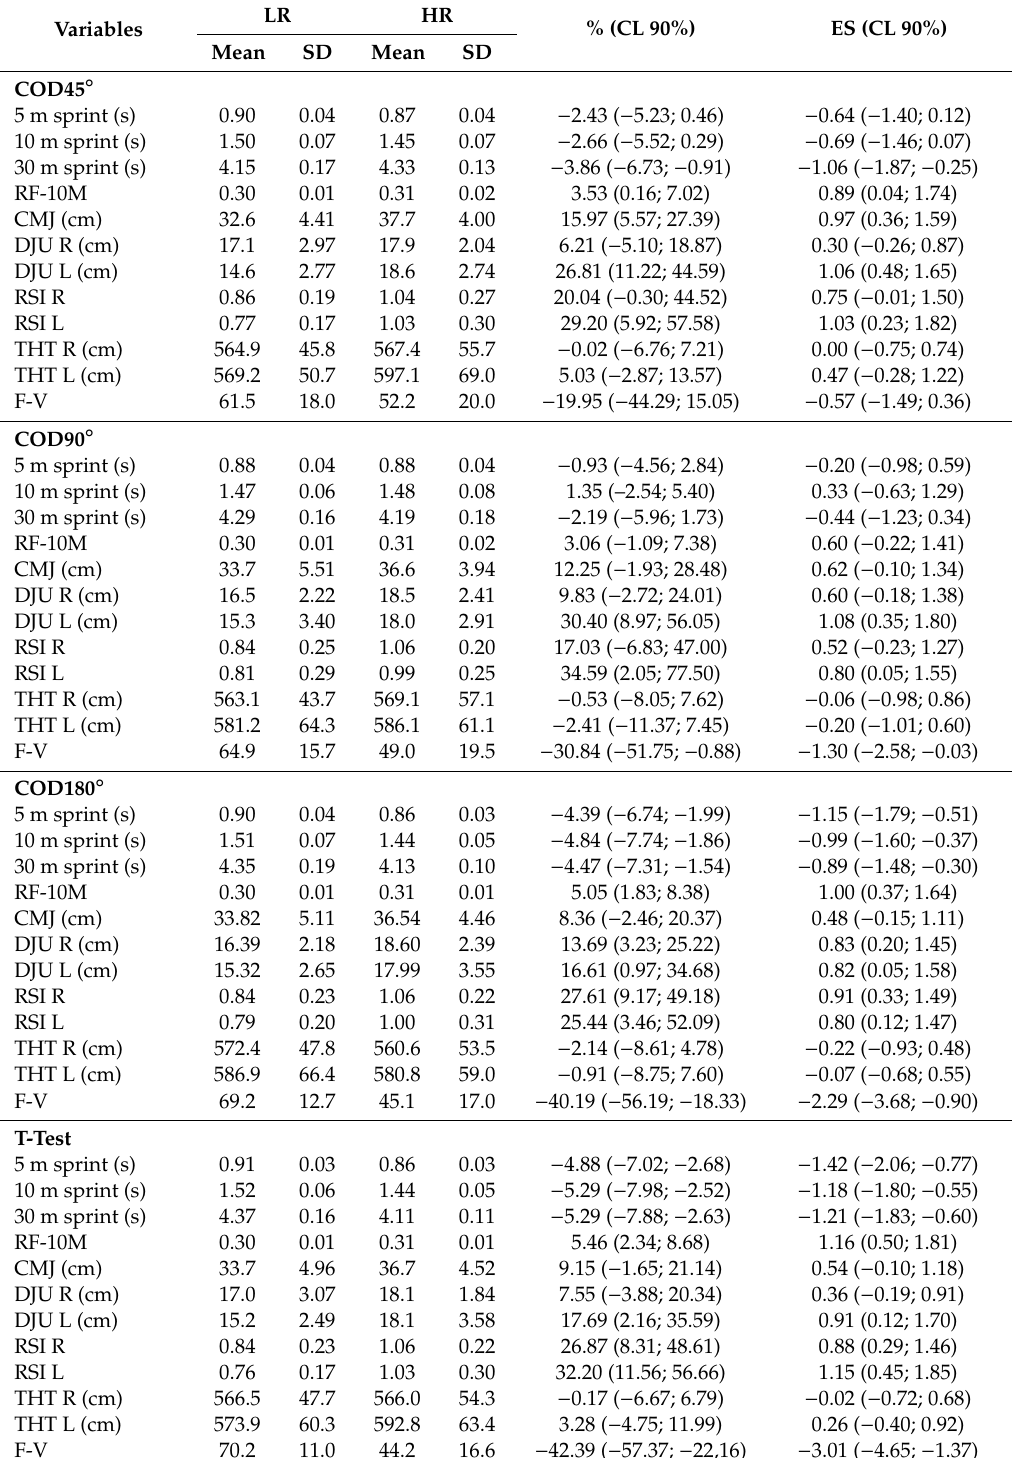
Table 2. Comparison of the 5, 10, and 30 m linear sprint, the rate of force at 10 m, the vertical jump through countermovement jump and drop jump unilateral, the reactive strength index, the horizontal jump through triple hop test, and the vertical force–velocity profile between low responders (LH) and high responders (HR) classified by each change of direction (COD) execution